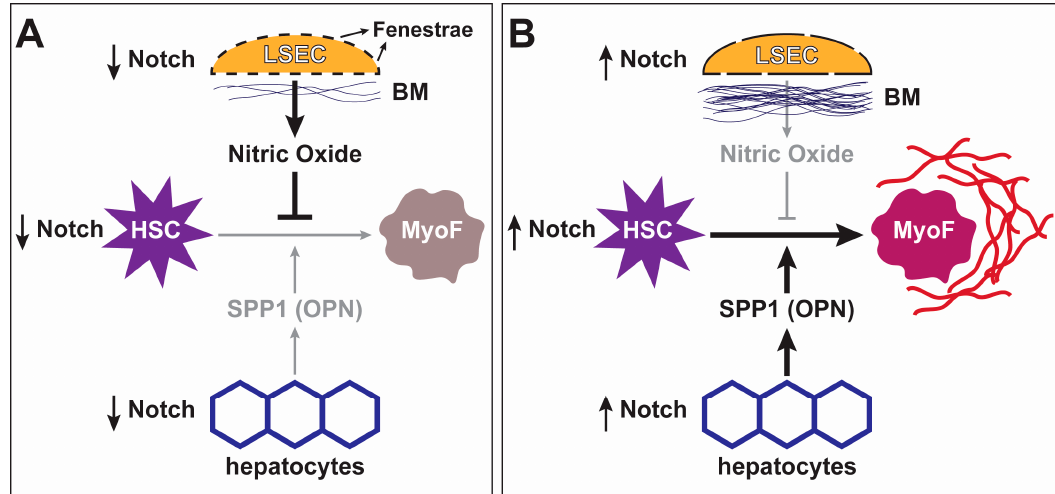
Figure 3. Notch signaling promotes Hepatic Stellate Cell (HSC) differentiation into myofibroblasts and liver fibrosis : ( A ) when Notch signaling is low, liver sinusoidal endothelial cells (LSECs) secrete nitric oxide, which inhibits the differentiation of hepatic stellate cells (HSCs) into myofibroblasts (MyoF). ( B ) Increased Notch activity in LSECs promotes their basement membrane (BM) production and reduces their fenestration and nitric oxide secretion, which in turn relieves nitric oxide’s inhibitory effect on HSC ‐ to ‐ myofibroblast differentiation. Additionally, increased Notch signaling in HSCs directly promotes their differentiation into myofibroblasts. Finally, activation of Notch signaling in hepatocytes promotes the secretion of SPP1 (OPN) by these cells, which also promotes myofibroblast differentiation. Myofibroblasts generated in response to increased Notch signaling promote liver fibrosis.